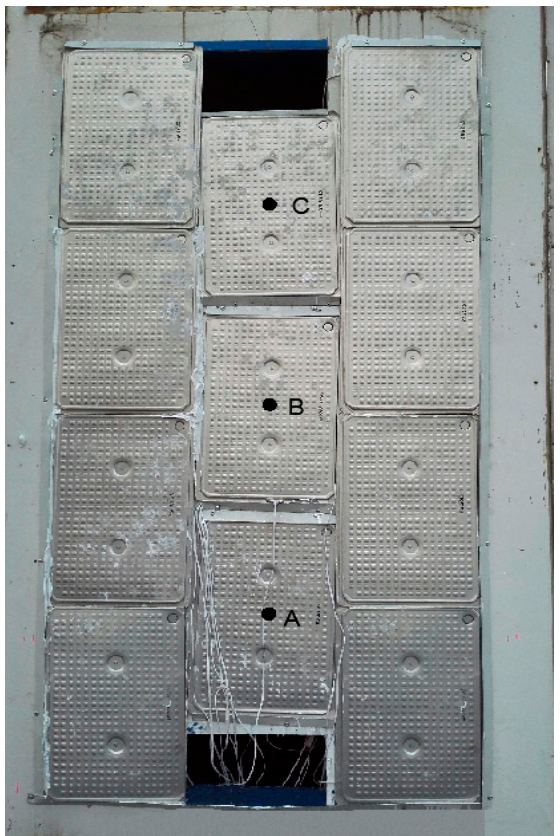
Figure 3. Arrangement of PCM plates and temperature monitoring points. Table 1. Parameters of the envelope structure of insulation wall and brick wall hot box.